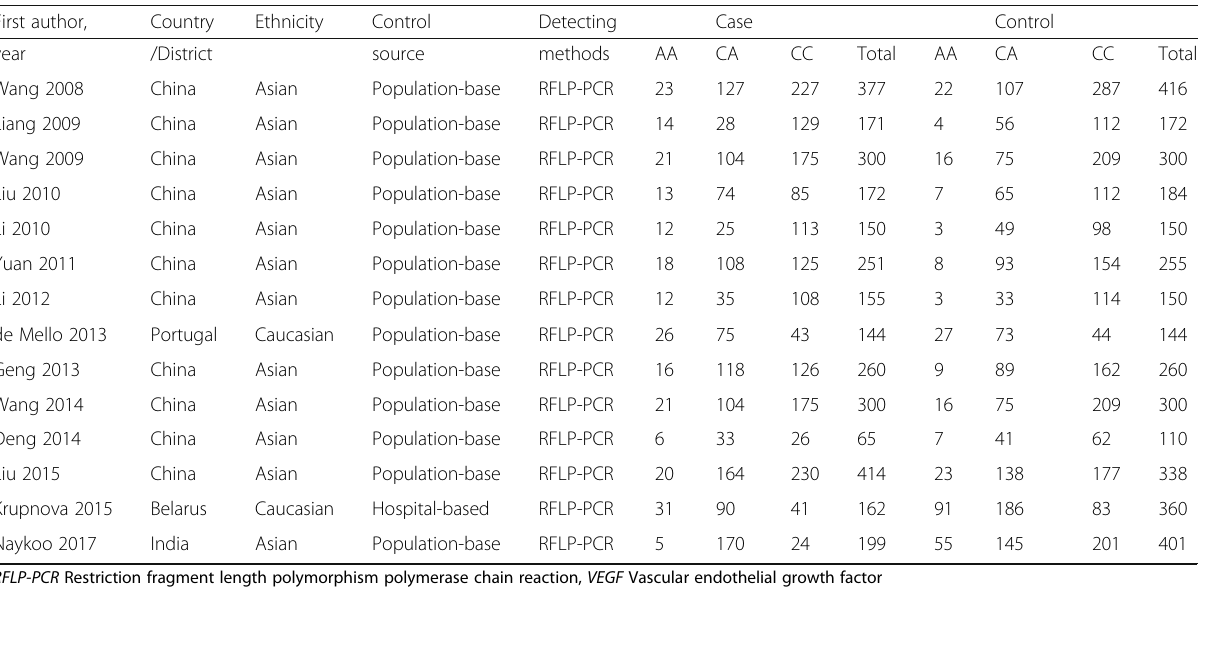
Table 1 General characteristics of the included studies in this meta-analysis for VEGF -2578C > A gene polymorphism with lung cancer risk